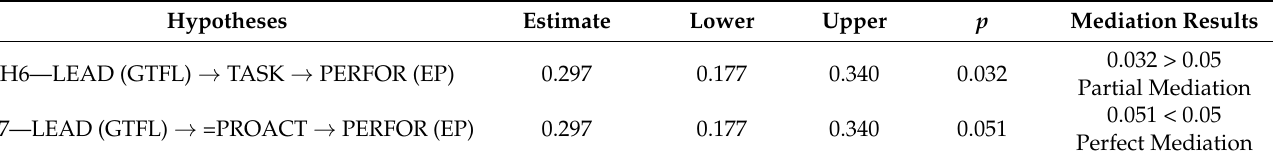
Table 5. Results of Mediation (developed by